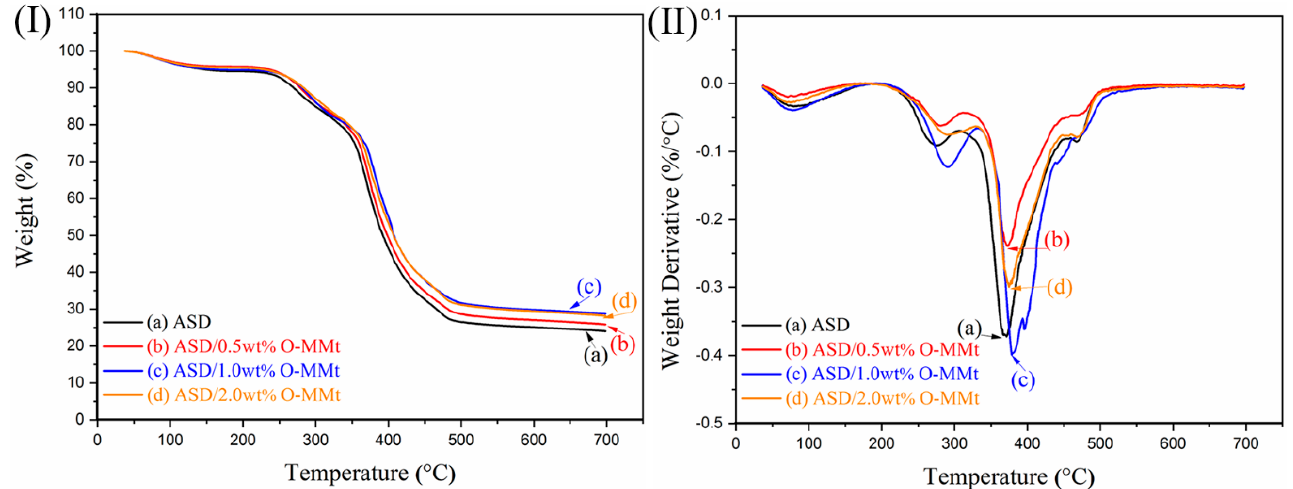
Figure 9. ( I ) TGA and ( II ) DTG curves of ( a ) ASD, ( b ) ASD/0.5 wt% O-MMt, ( c ) ASD/1.0 wt% O-MMt, and ( d ) ASD/2.0 wt% O-MMt.